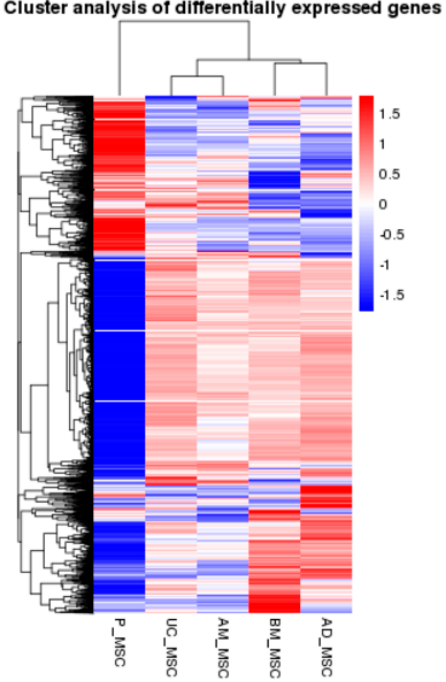
Figure 5. Dendrogram and unsupervised hierarchical clustering heat map (using Euclidean distance) of gene expression, based on the log ratio fragments per kilobase of exon model per million reads mapped (FPKM) data. Each column represents an experimental condition; each row represents a gene. For differentially expression genes, their log2 (RPKM) will be clustered. Red indicates up-regulation, and blue indicates down-regulation. The vertical distances on each branch of the dendrogram represent the degree of similarity between gene expression profiles of the five MSC groups.